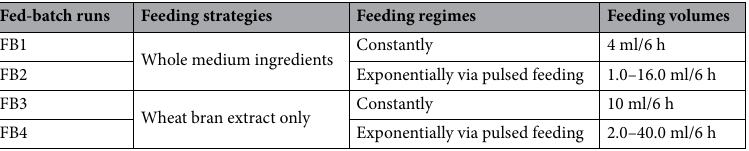
Table 11. Optimization of the fungal biomass and MnO NPs production by studying different feeding strategies , feeding regimesandfeeding volumes through controlled fed-batch fermentation modeusing7L bioreactor.